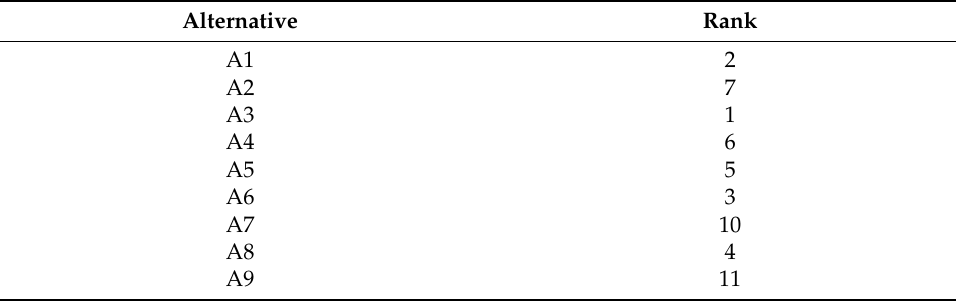
Table 20. Ranking of alternatives by RAPS